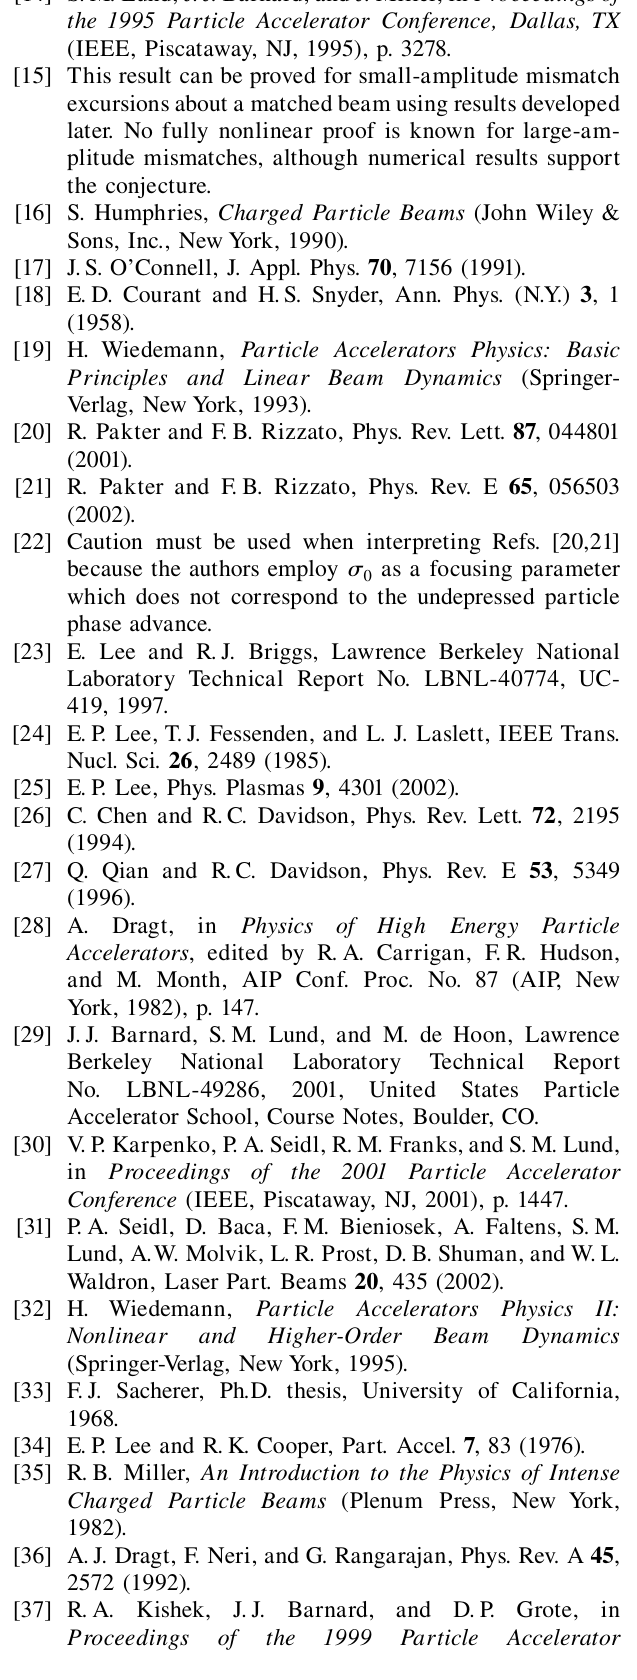
using the constraint equation 0 (cid:3) L= 2 (cid:4) in terms of (cid:24) . 0 (cid:5)